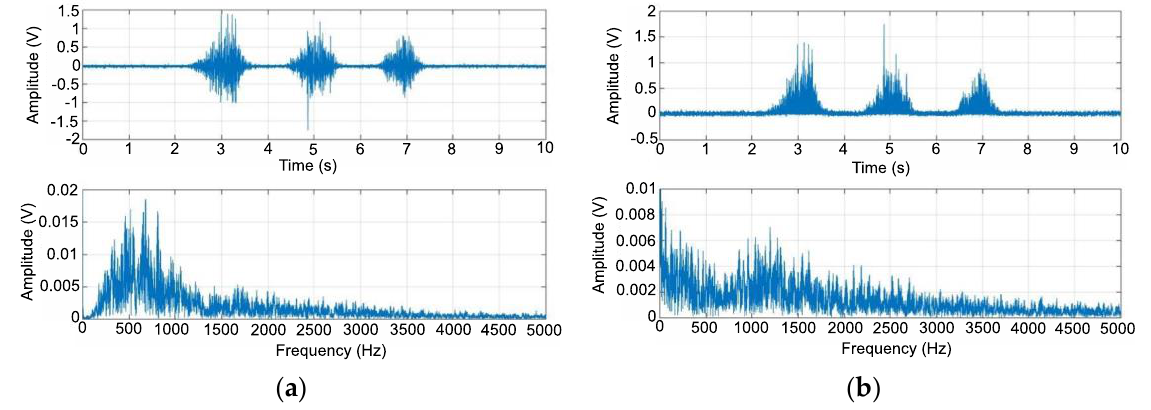
Figure 10. EMG signal as a function of time and frequency after high-pass filtering ( a ), EMG signal as a function of time and frequency after full-wave rectification ( b ).